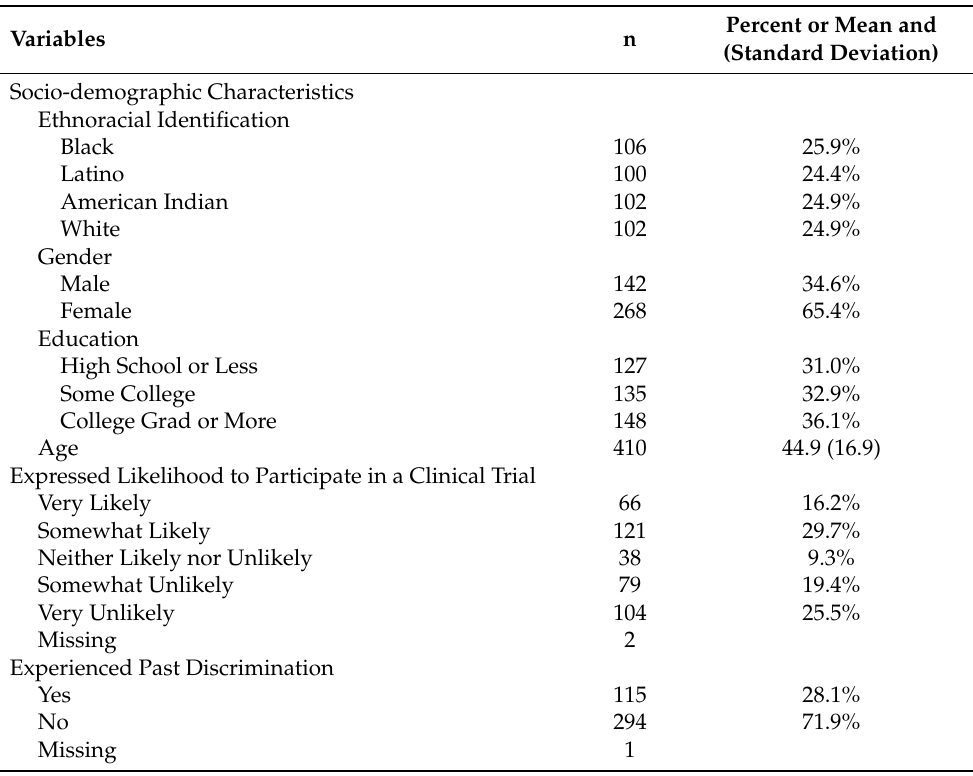
Table 1. Descriptive Statistics of Respondents’ Socio-demographic Characteristics, Expressed Likeli- hood to Participate in a Clinical Trial, and Experienced Past Racial